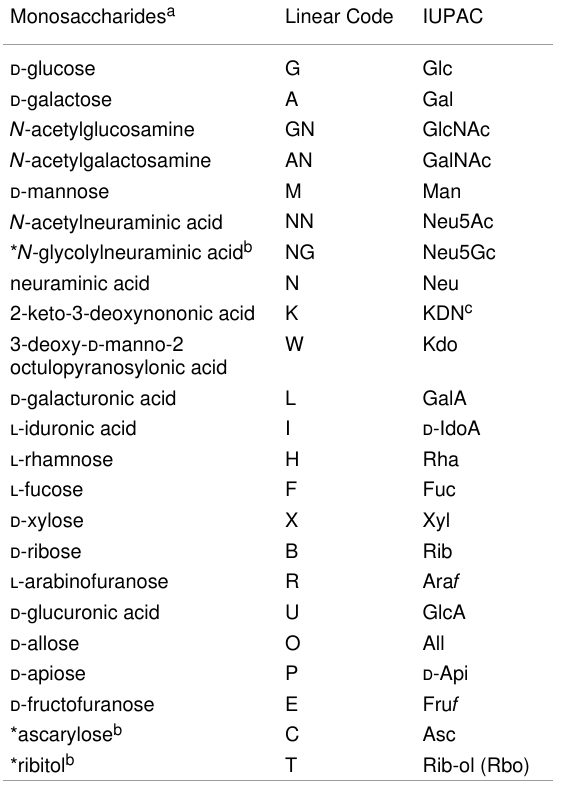
Table 4: Common monosaccharides and their Linear Codes (adapted from [31]). We have added NG as it has become a clearly important monosaccharide excluded from the original list. Full monosaccharide descriptions are recorded in IUPAC [18]; all terms can be found at https://www.qmul.ac.uk/sbcs/iupac/2carb/38.html.